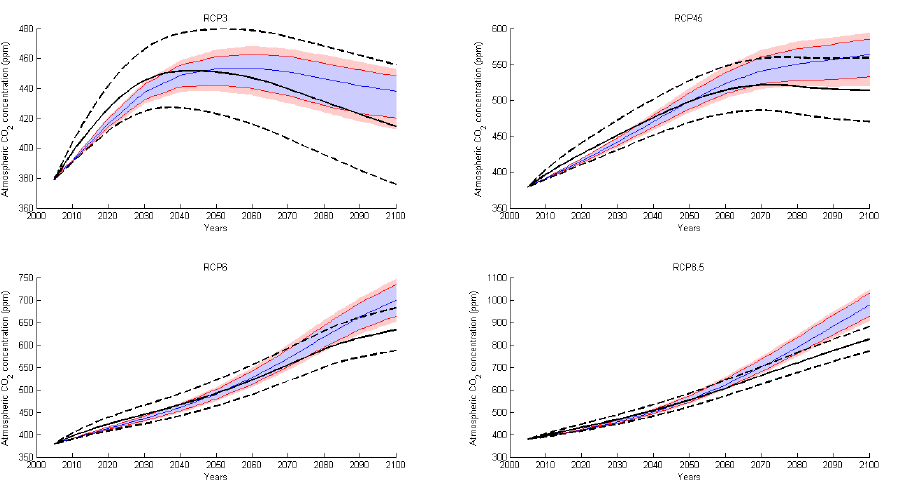
Figure A3. TIAM-World climate module: Uncertainty in the carbon cycle against MAGICC6 ranges for the four RCP